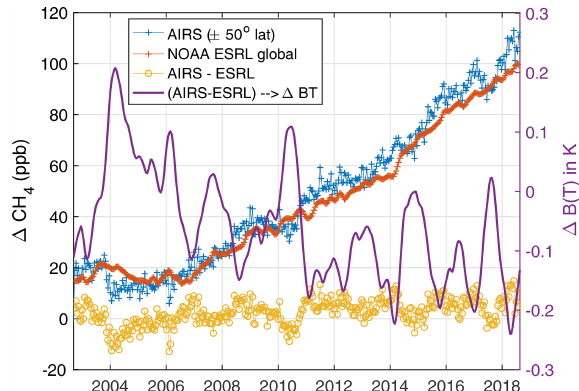
Figure 13. Retrieved CH 4 anomalies compared to ESRL global in situ data. The CH 4 anomaly difference between AIRS and ESRL is shown in yellow. The magenta curve is that difference converted into BT units.